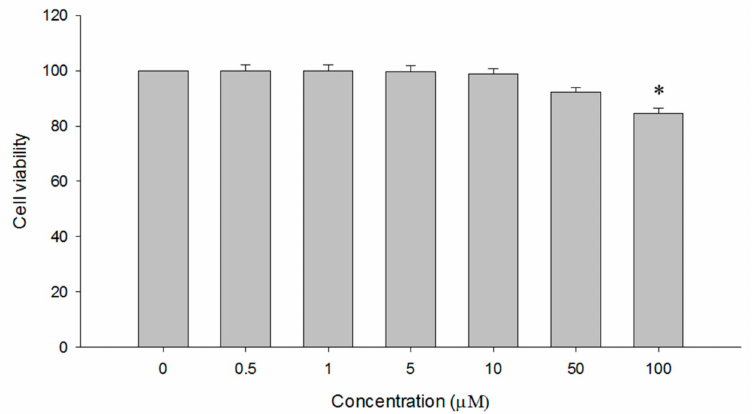
Figure 9. Cytotoxicity of CK41016 in Caco-2 cells ( n = 6, mean ± SD, * p < 0.05 between control).